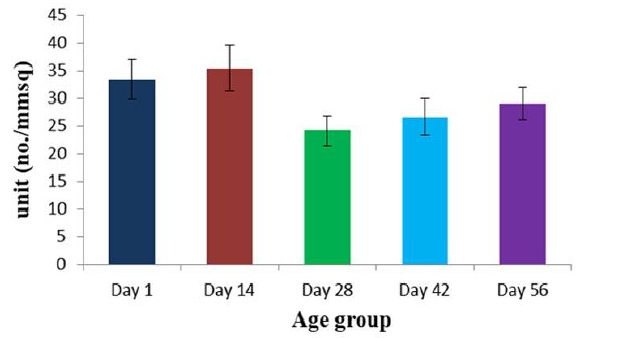
Figurer 4 . Analysis of glands of Lieberkuhn/mmsq (mean±standard error mean).